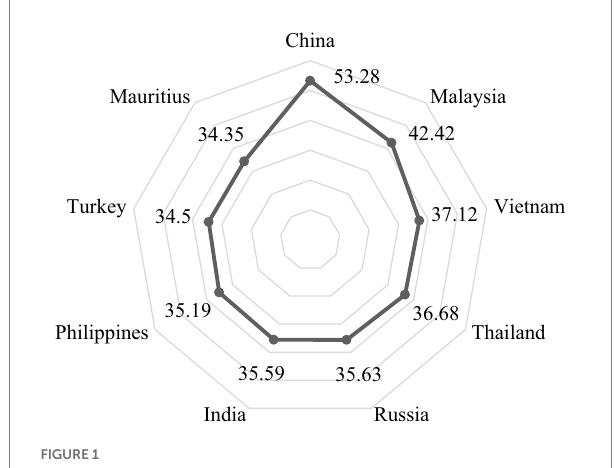
FIGURE 1 Global Innovation Index in emerging economies of the sample in 2020, score 0–100. Built by the authors based on WIPO